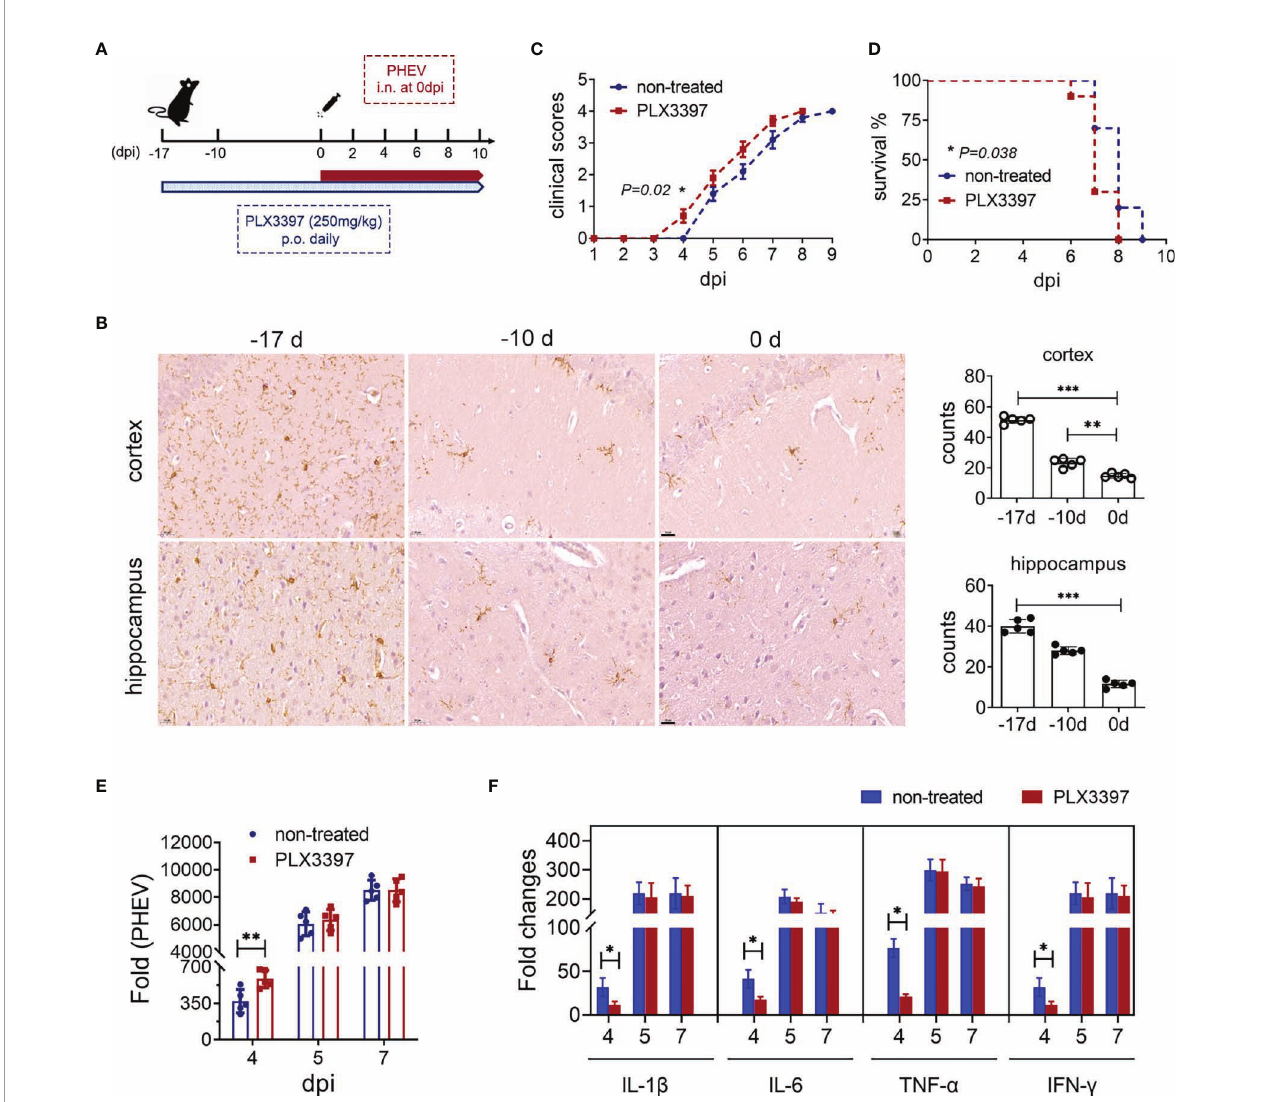
FIGURE 2 | Administration of PLX3397 facilitates early infection of PHEV. (A) Procedure of PLX3397 administration and PHEV infection. (B) Microglial depletion was evaluated by Iba1 immunostaining. Iba1 + cells in the hippocampus and cortex were quanti fi ed in the right panels. Each column represents the mean ± SD for 5 fi elds in each group. Bars, 20 m m. (C) Clinical scores. (D) Survival curves. (E) PHEV mRNA expression was detected using qRT – PCR. (F) The expressions of IL-1 b , IL-6, TNF- a , and IFN- g were detected by qRT – PCR. Student ’ s t test (*, P<0.05; **, P<0.01; ***,